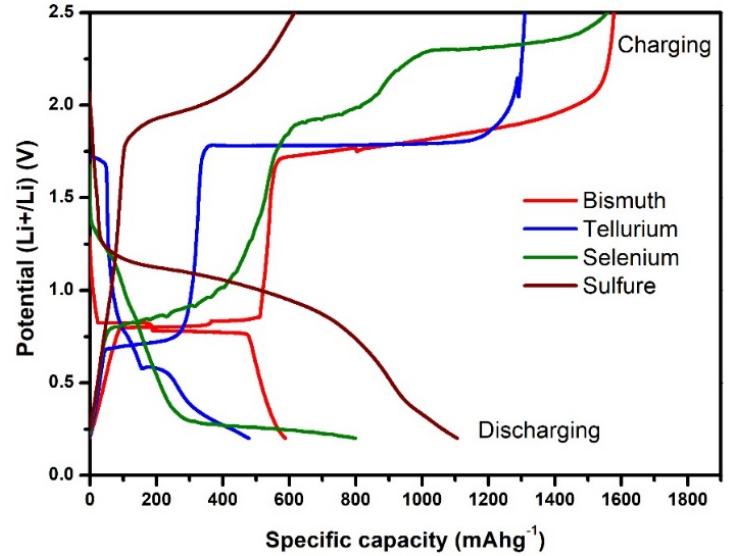
Figure 10. Galvanostatic charging-discharging curve for the first cycle of Bi, S, Se, and Te in the potential window of 0.1–2.5 V.